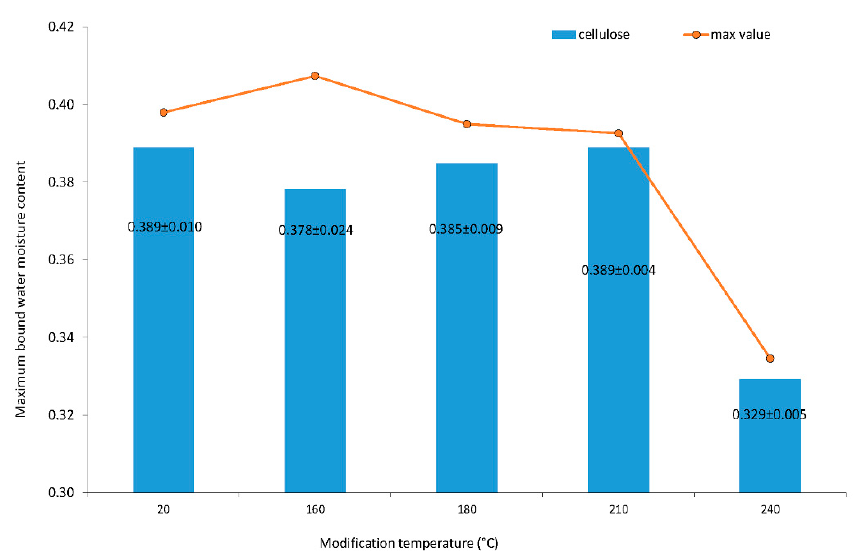
Figure 3. Maximum bound water moisture content of cellulose. Numbers following the averages are standard deviations from the measurement of 3 specimens.